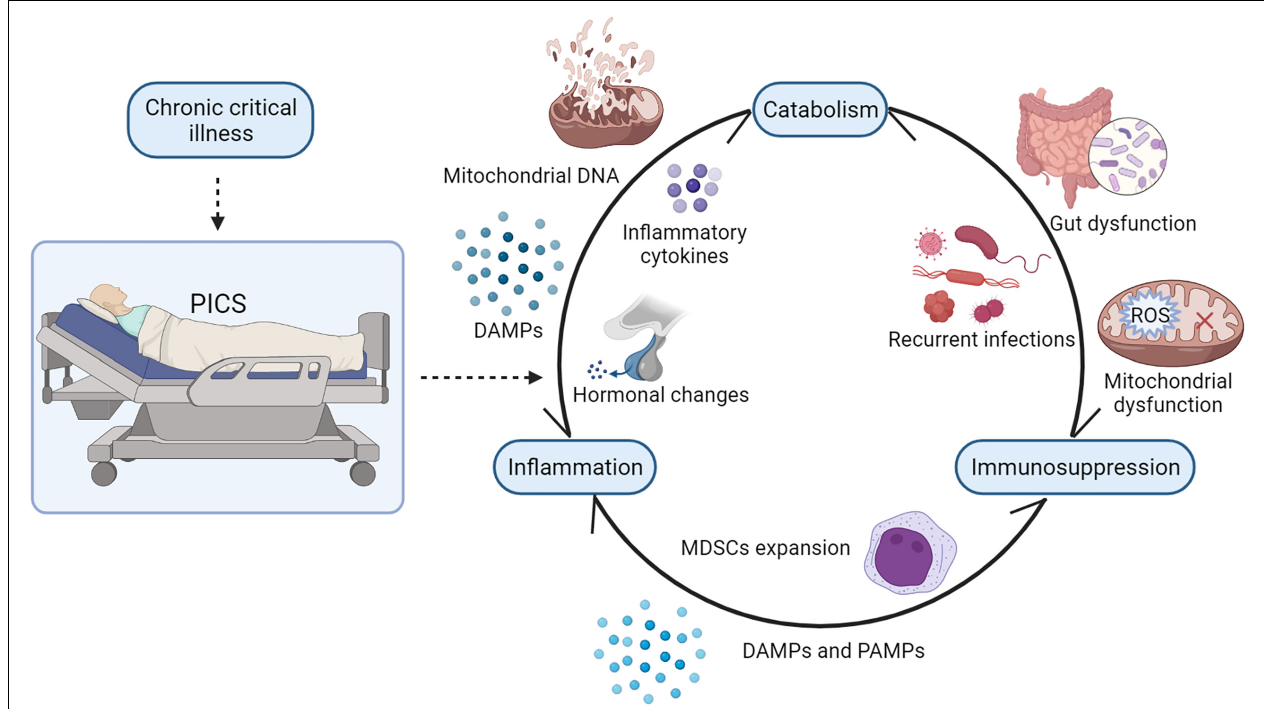
FIGURE 3 | The vicious cycle of PICS. There is a strong interaction between persistent inflammation, immunosuppression, and catabolism. In PICS, ongoing catabolism results in malnutrition and muscle wasting, and its decomposition products such as mitochondrial DNA and other DAMPs may drive persistent low-grade inflammation. Mitochondrial dysfunction and gut dysfunction impair ATP production and, consequently, suppress immunity. Persistent inflammation induces the release of inflammatory cytokines and hormonal changes in patients with PICS, contributing to hypercatabolism. Besides, persistent inflammation also induces inappropriate bone marrow hyperplasia, causing the dramatic expansion of MDSCs in patients with PICS, which will inhibit the proliferation of immune cells. Suppressed immunity causes recurrent infections and inflammatory responses, which consume energy and nutrients. PICS, persistent inflammation, immunosuppression, and catabolism syndrome; MDSCs, myeloid derived suppressor cells; DAMPs, damage-associated molecular patterns; PAMPs, pathogen-associated molecular patterns. SCFAs, short-chain fatty acids; ROS, reactive oxygen